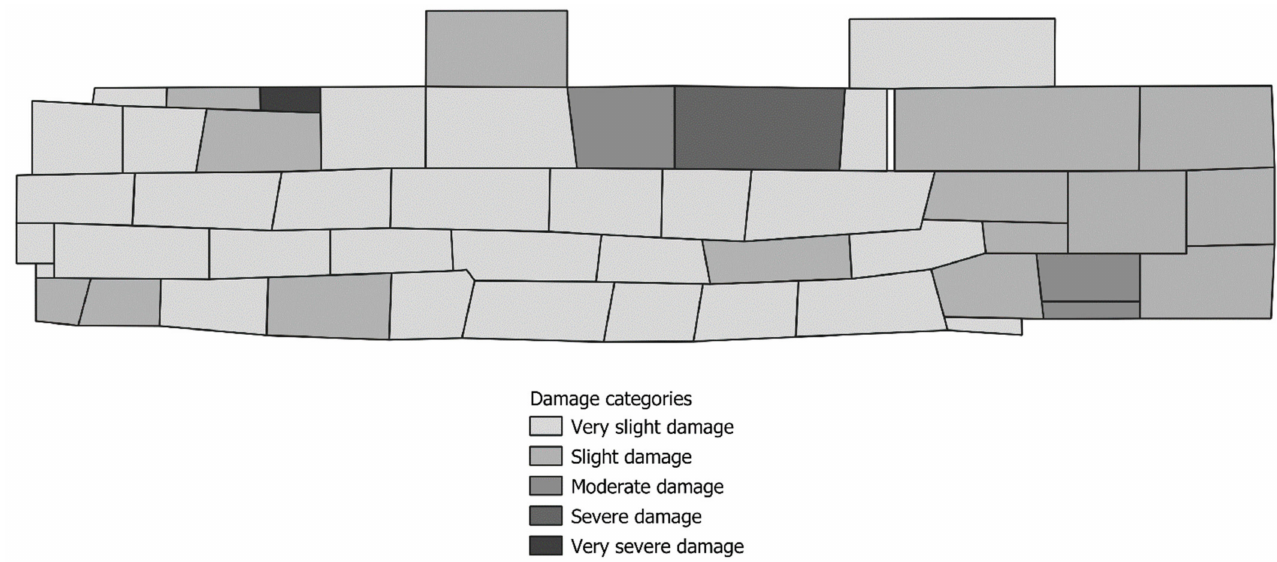
Figure 12. Damage index map, cella wall remains at the Temple of Athena and Zeus